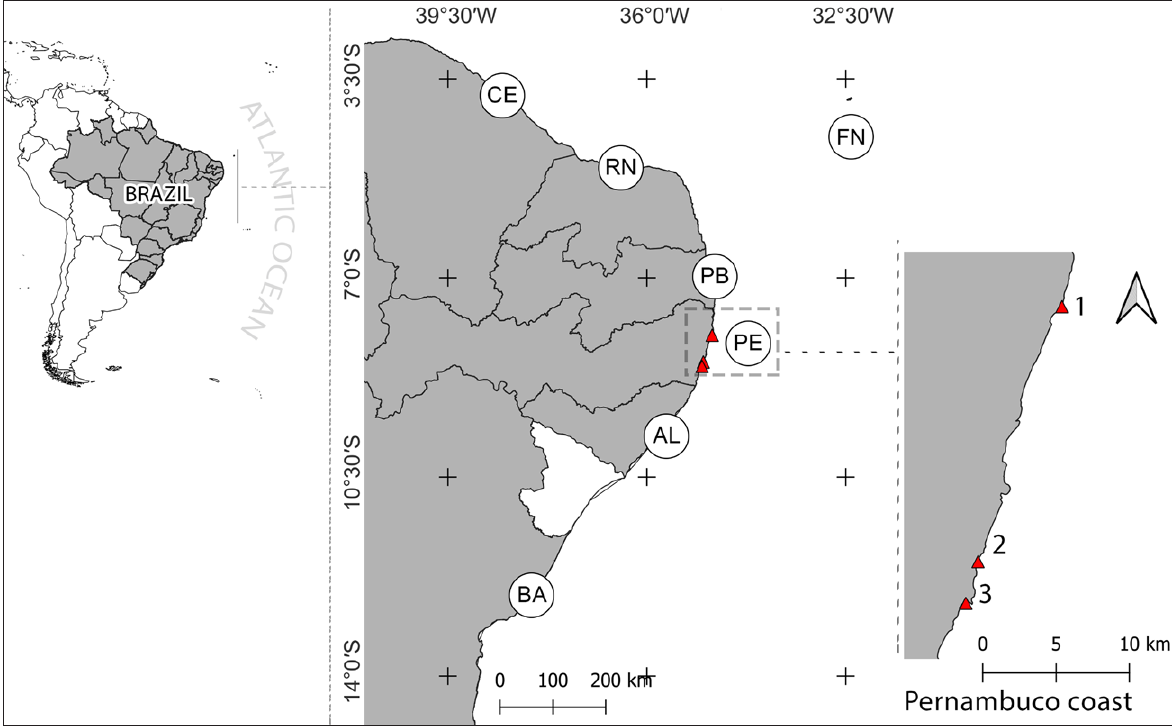
Figure 1. Distribution of Isaurus tuberculatus along the Brazilian coast and location of studied populations. Black circles = previous pub- lished records; gray circles = previous unpublished records (gray literature); red circles = new records, studied populations. Abbreviations and sources of data: CE = Ceará (Morandini et al. 2006; Rabelo and Matthews-Cascon 2007; Soares et al. 2011); RN = Rio Grande do Norte (Gondim et al. 2020); FN = Fernando de Noronha Archipelago; PB = Paraíba (Gondim et al. 2020); PE = Pernambuco (Laborel 1970; Gondim et al. 2020); AL = Alagoas (Gondim et al. 2020); BA = Bahia (Grohmann and Peixinho 1995; Gondim et al.